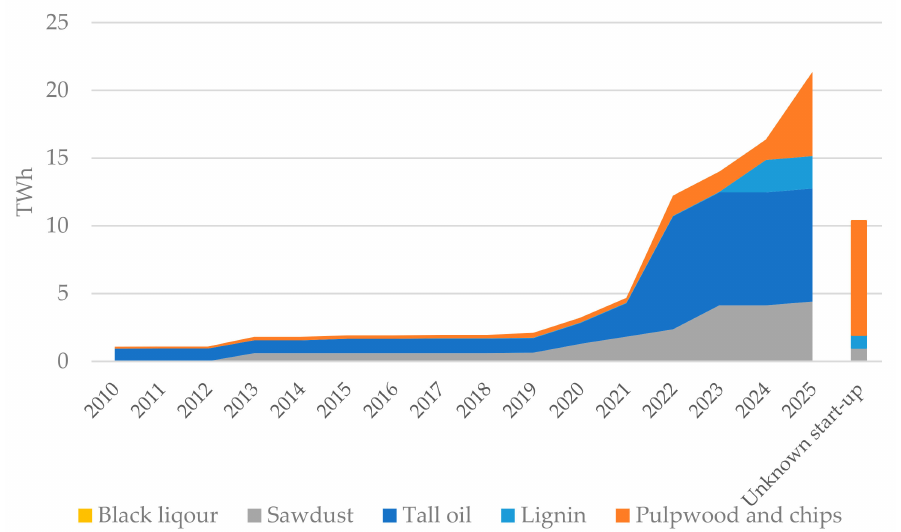
Figure 2. Identified planned liquid forest-based biofuel production capacity (accumulated) in Norway, Sweden and Finland for the period 2010–2025, and additional production capacity in projects with unknown start-up dates that may be regarded as uncertain. Source: